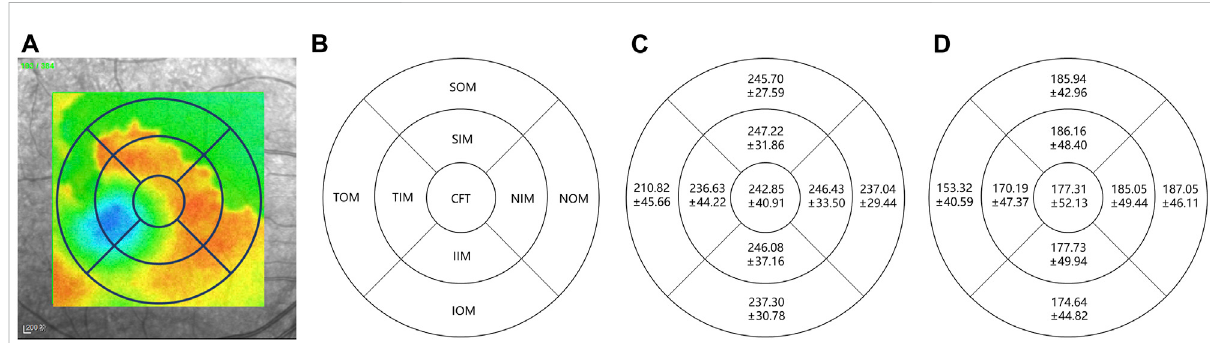
FIGURE 11 Choroidallayerthicknessmapinnormalandhighly myopicsubjectsusingEarlyTreatmentDiabeticRetinopathy Study(ETDRS)circlesof1 mm, 3 mm, and 6 mm. The standard ETDRS sub fi elds dividing the macula into 9 sub fi elds. CFT: Central foveal thickness; TIM: Temporal inner macula; NIM: Nasal inner macula; SIM: Superior inner macula; IIM: Inferior inner macula; TOM: Temporal outer macula; NOM: Nasal outer macula; SOM: Superioroutermacula;IOM:Inferioroutermacula. (A) denotesthethicknessmapinnormalsubject, (B) denotesthe9sub fi eldsofmacula, (C,D) denote the average choroidal thickness [ μ m] of sub fi elds in normal subjects and highly myopic, respectively.